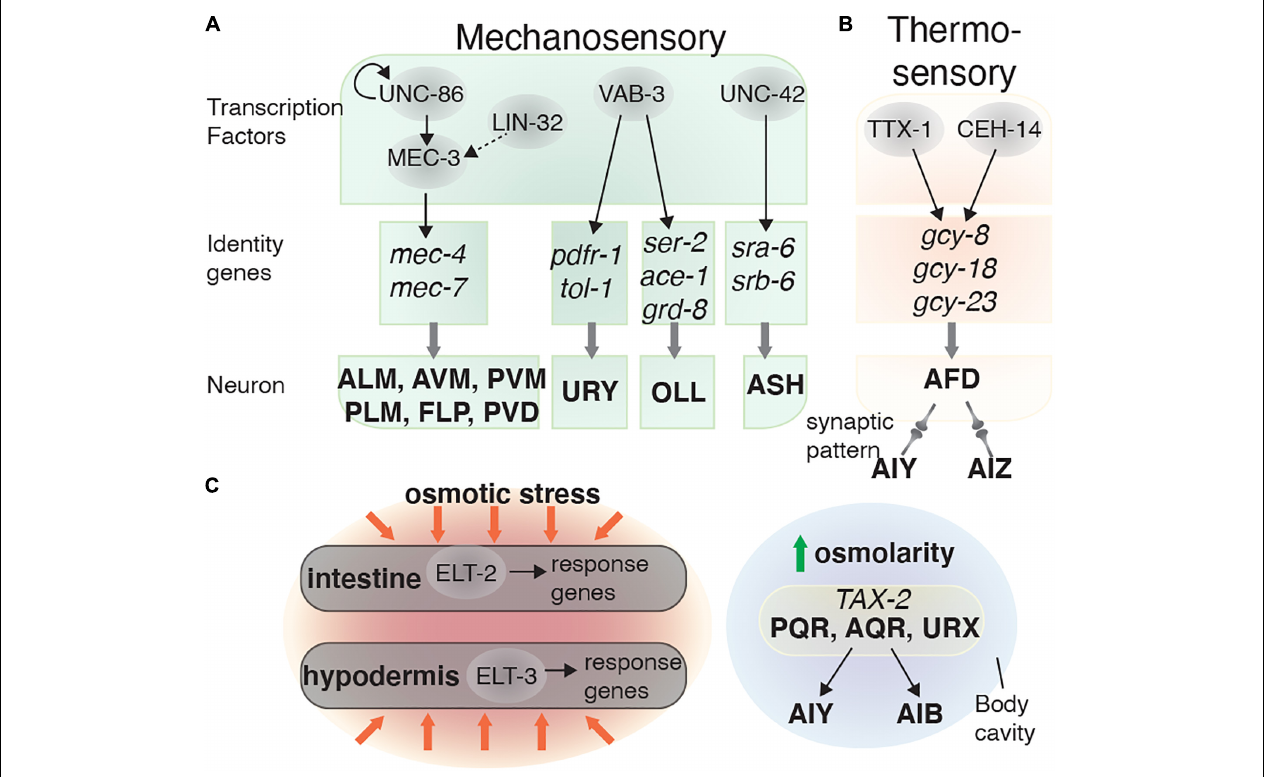
FIGURE 3 | Transcriptional regulatory networks in mechanosensory and thermosensory neurons. Transcription factors are depicted in gray circles. How these transcription factors interact and the identity genes they regulate are shown for the: (A) Mechanosensory and (B) AFD (thermosensory) neurons. (C) Osmolarity sensation is mediated by neurons and non-neuronal tissues (intestine and